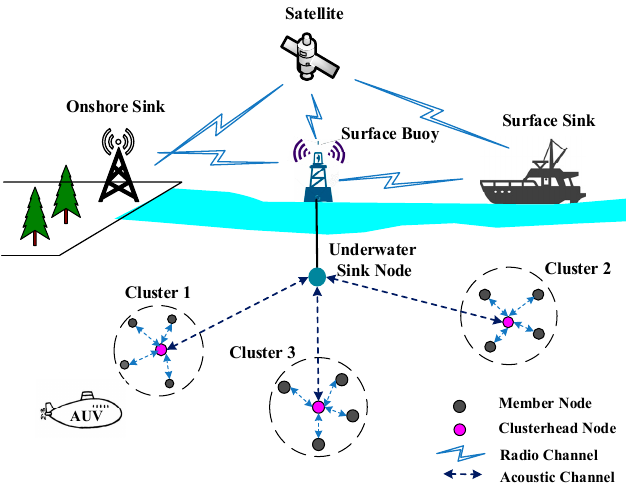
Figure 1. Underwater wireless sensor network (UWSN) architecture.